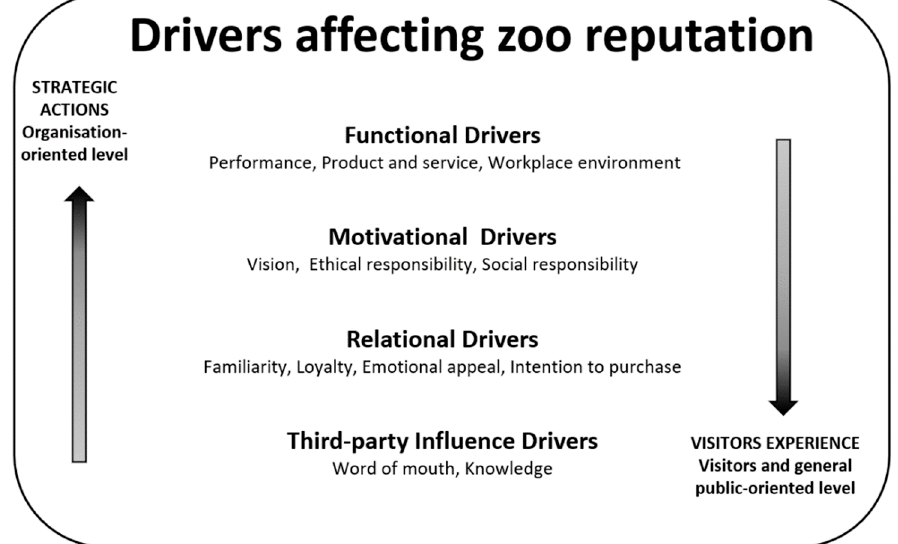
Figure 2. Drivers affecting zoo reputation analyzed in ZERS.